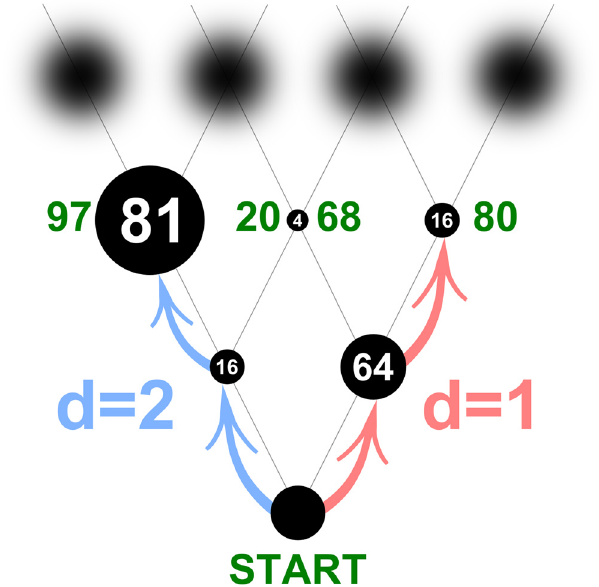
Fig 1. Binary decision tree. Moving up from the START disk, actors make sequential binary choices between the rewards represented by disk sizes (displayed inside the disks). The task is binary in that the actor has to choose between two alternatives on every step: upward left or upward right. Actors characterized by different depths of computation d will choose different paths. The short-sighted actor with depth d = 1 (red) will collect 80 points (displayed in green in the third row). The more far-sighted actor with depth d = 2 (blue) will collect 97 points.